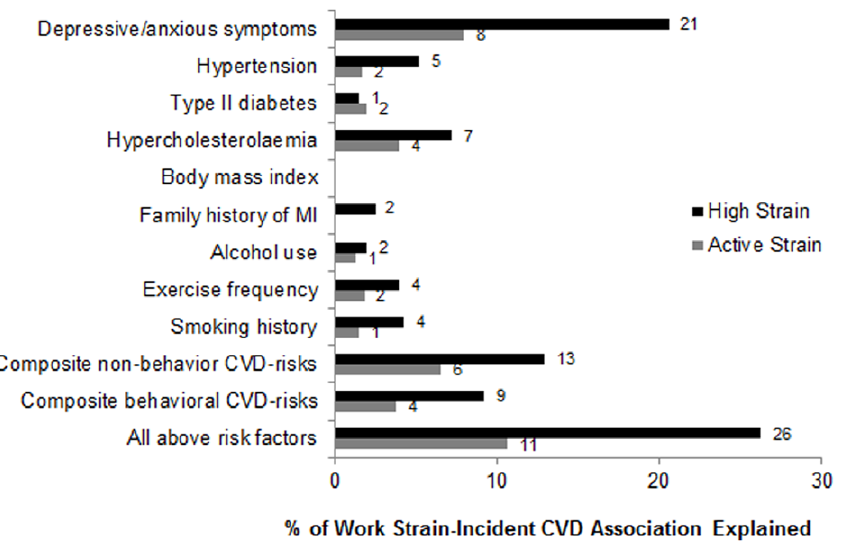
Figure 2. Percentage of work strain-incident CVD associations that are explained by potential mediators (N=17,415). The proportion of the risk attributable to high strain and active jobs (relative to low strain) that is explained by each mediator (or set of mediators) is calculated as follows: (HR base model – HR adjusted model )/ (HR base model –1) 6 100%. 1 Composite of traditional non-behavioral risk factors includes hypertension, diabetes, hypercholesterolaemia, body mass index, and parental history of MI before age of 60 years. 2 Composite of behavioral risk factors includes alcohol use, exercise frequency, and smoking history.